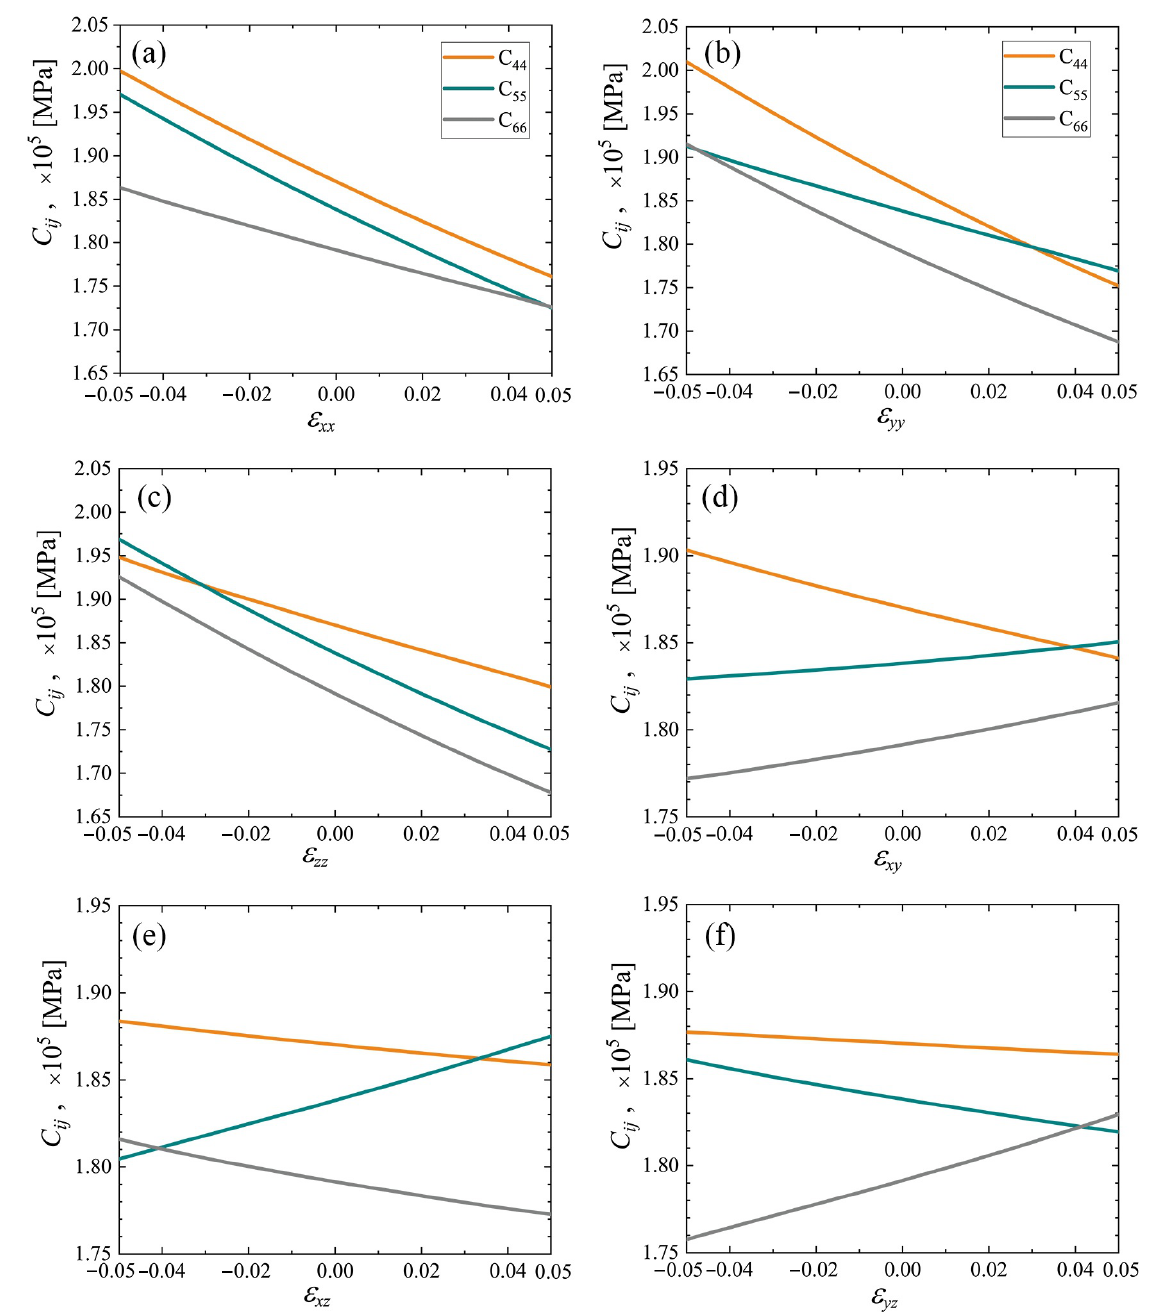
Figure 10. The same as in Figure 9, but for the triclinic crystal. Panels ( a – f ) correspond to changing ε xx to ε yz ,